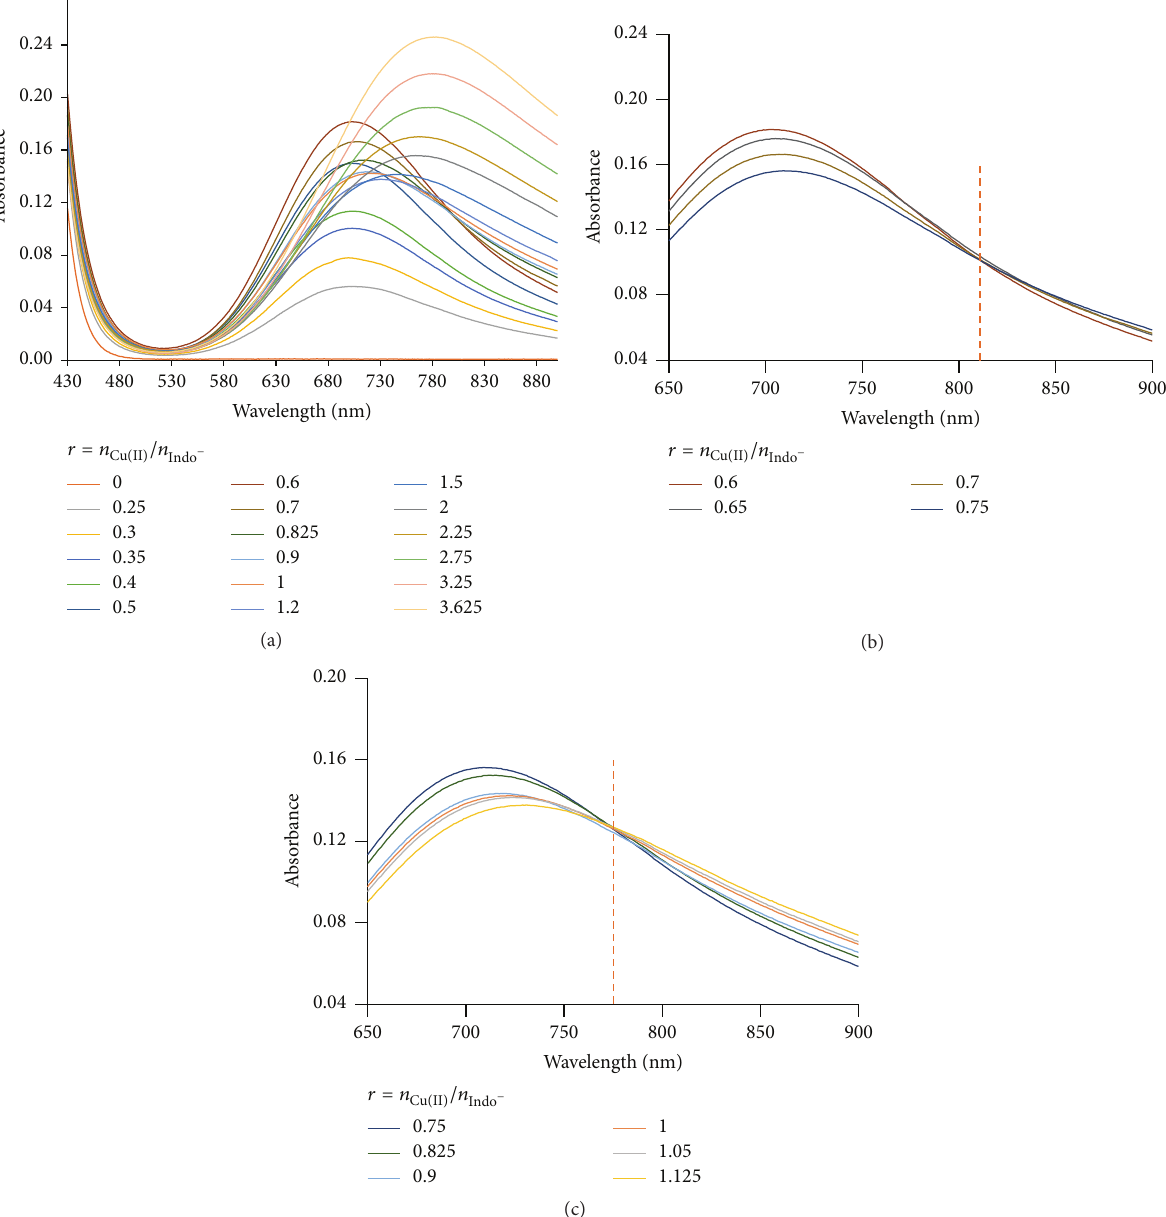
Figure 1: (a) UV-Vis spectra of Cu(II)–Indomethacin in ethanol applying the molar ratio method with fixed concentration of Indo − and variable concentration of Cu(II). (b) Isosbestic point at 𝜆 ≈ 812 . (c) Isosbestic point at 𝜆 ≈ 775